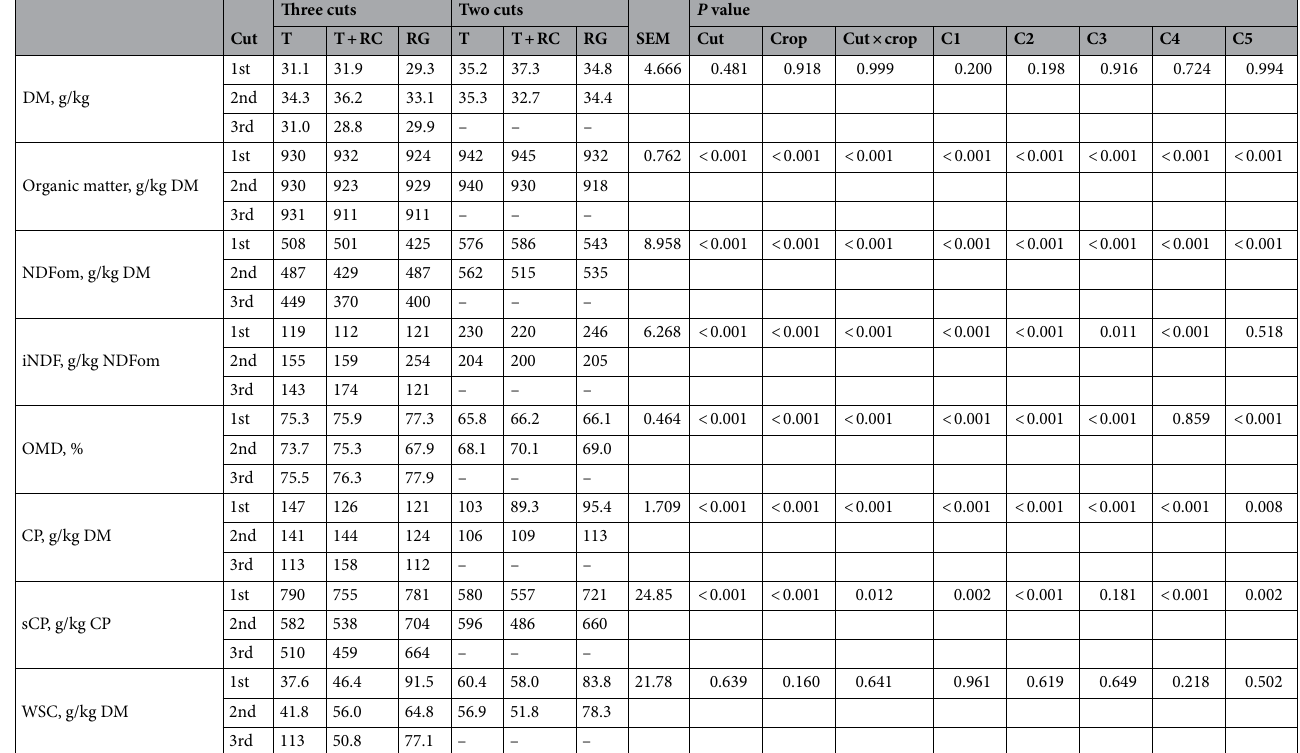
Table 2. Effect of Cut (1–5 where 1,3 and 5 is the first, second and third cut in the three-cut system, and 2 and 4 is the first and second cut in the two-cut system) and crop (T, Timothy; T + RC, Timothy + red clover; RG, perennial ryegrass) on silage feed quality parameters averaged across DM and additive treatments (n = 4). DM, dry matter; NDFom, neutral detergent fibre; iNDF, indigestible NDF; OMD, organic matter digestibility; CP, crude protein; sCP, soluble crude protein; WSC, water-soluble carbohydrates. C1 is the contrast three versus two cuts per season overall; C2 is the contrast three versus two cuts per season, 1st cut; C3 is the contrast three versus two cuts per season, 2nd cut; C4 is the contrast T versus RG; C5 is contrast T versus T +